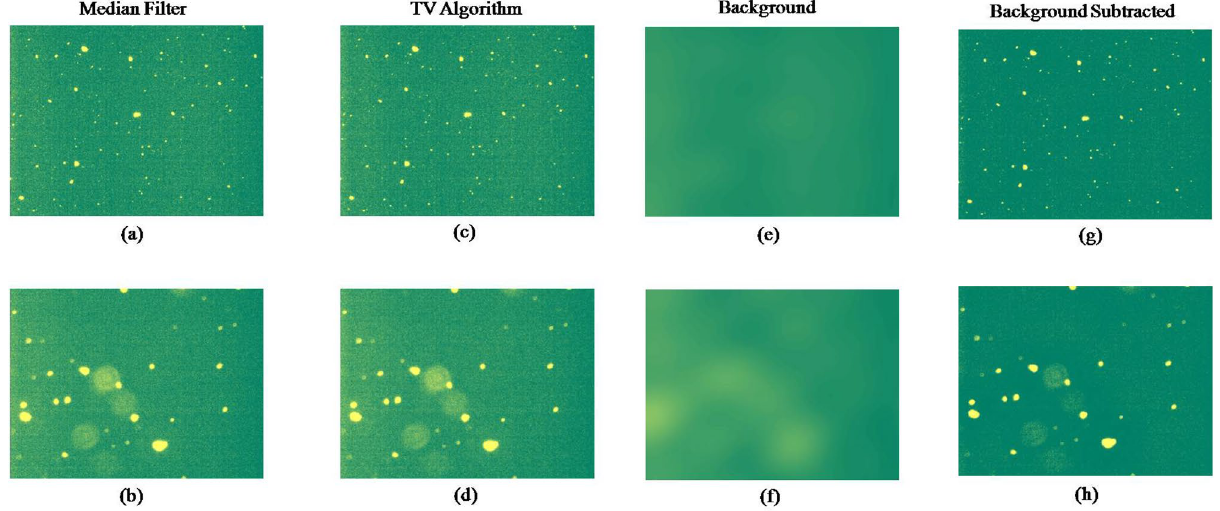
Figure 5. Various images obtained after applying de-noising algorithm on Fig. 4b,c. ( a ) and ( b ) are the median filtered output of Fig. 4b,c. ( c ) and ( d ) are the output after applying TV algorithm, ( e ) and ( f ) are the background and ( g ) and ( h ) are the background subtracted output of Fig.